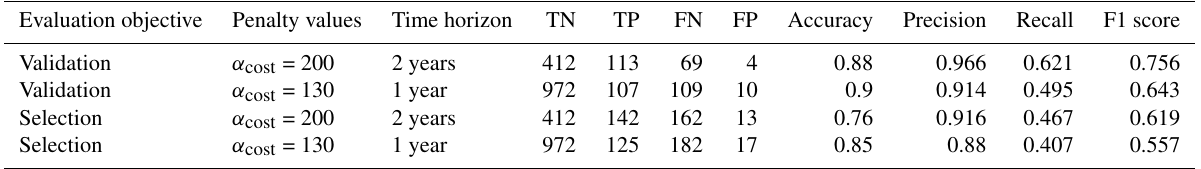
Table 3. Conservative penalty choices and their performance for Laplace kernels and batch-SD. Evaluation